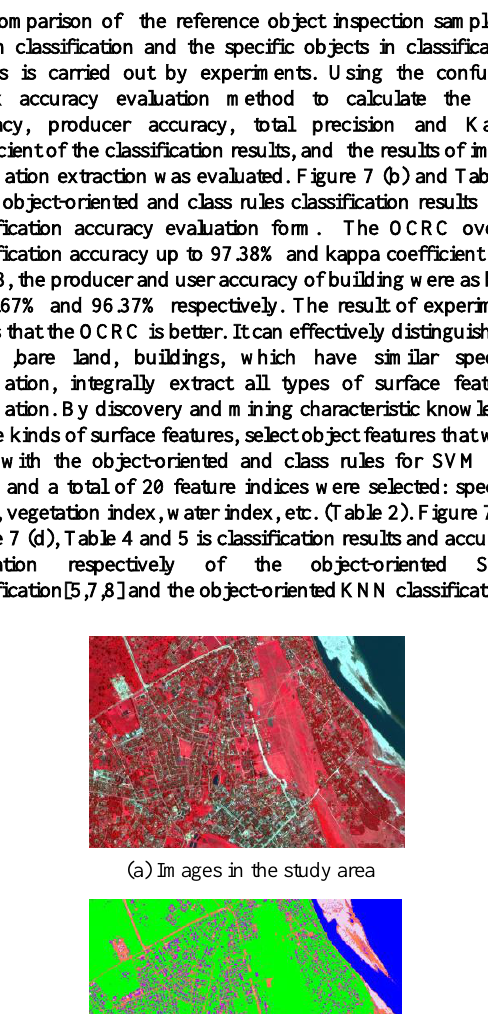
Table 2. Total of image objects features